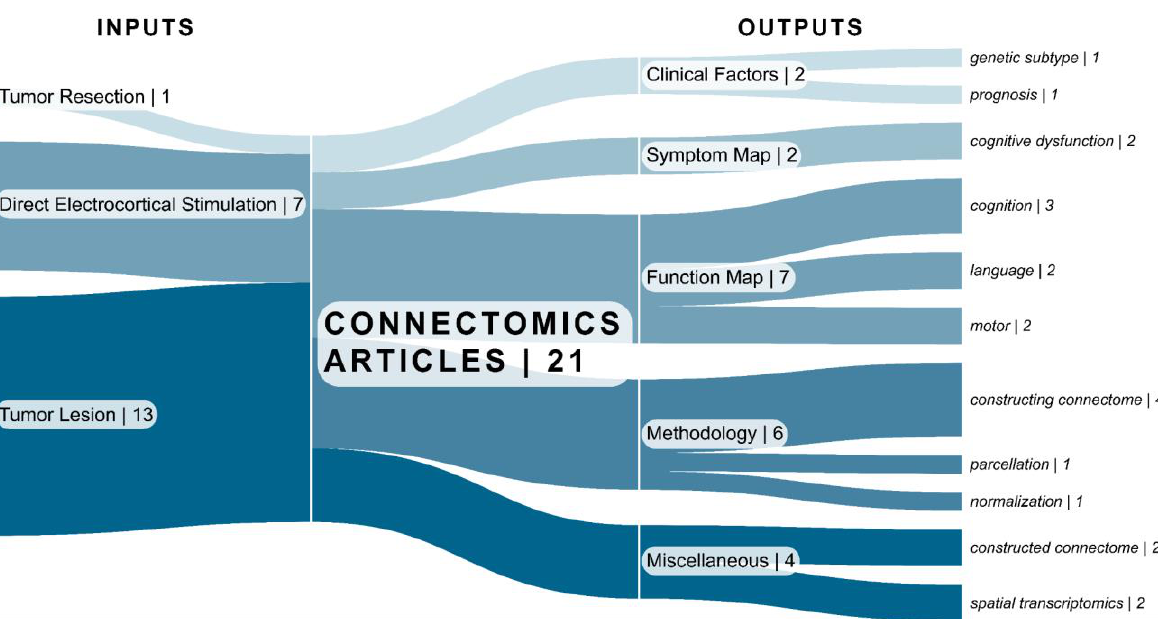
Figure 5. Sankey diagram of studies that utilized connectomics, representing the flow of input data sources and output objectives. The left side of the diagram indicates study input data sources and the right side denotes study data output objective.